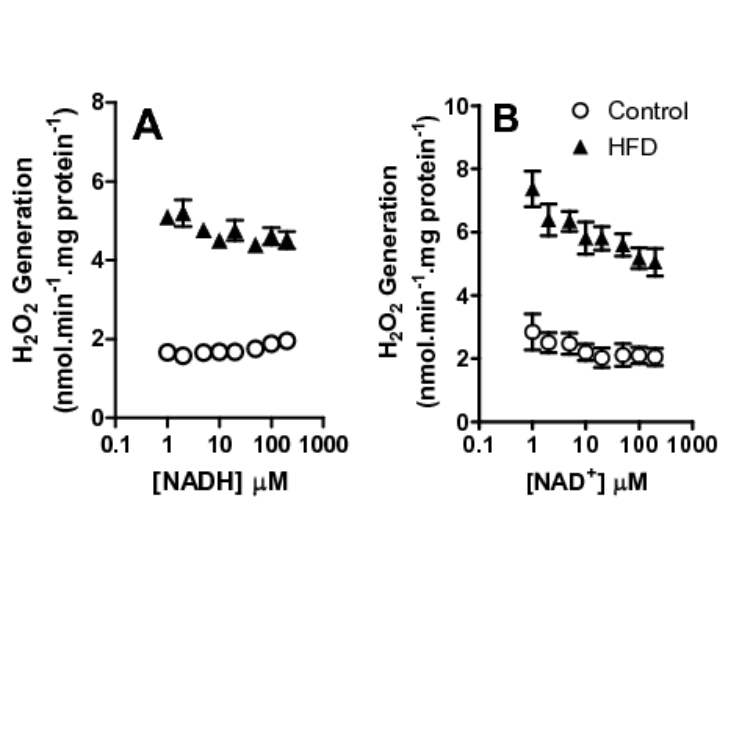
Figure 7. NAD + prevents H O release by VLCAD. Frozen and defrosted mitochondria (0.2 mg protein. mL -1 ) were incubated 2 2 under the conditions of Figure 6B, in the presence of varying NADH (Panel A) or NAD + (Panel B) concentrations, as indicated. H release was monitored as described in Materials and Methods, n = 6 per